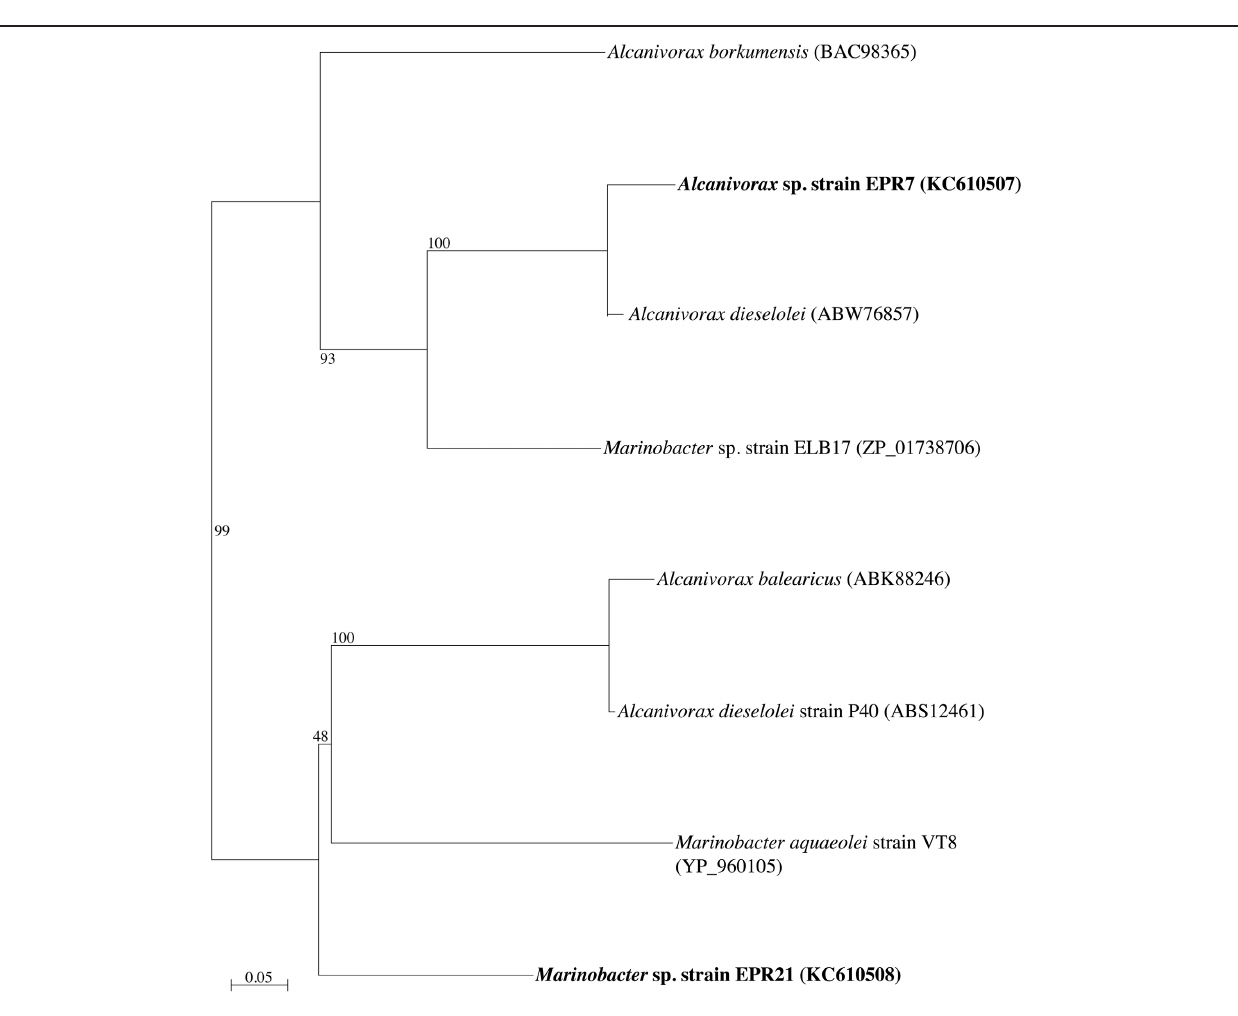
FIGURE 2 | Neighbor-joining phylogenetic tree inferred from amino acid sequences deduced from the nucleotide sequence of a fragment of the alkB gene (encoding for the alkane hydroxylase), showing the position of Alcanivorax sp. strain EPR7 and